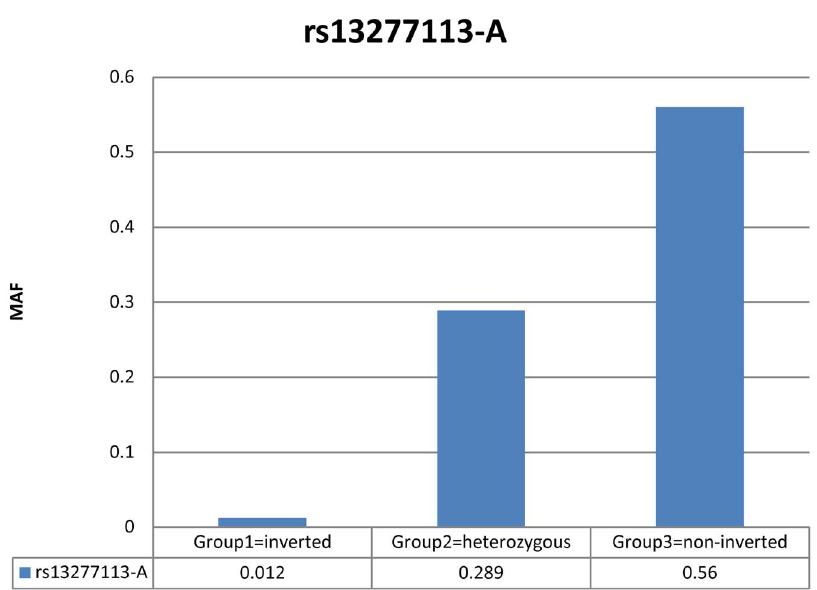
Fig. 3. Comparisons of minor allele frequency differences of a known published SNP associated with lupus (rs13277113) in 3 different Caucasian subgroups.